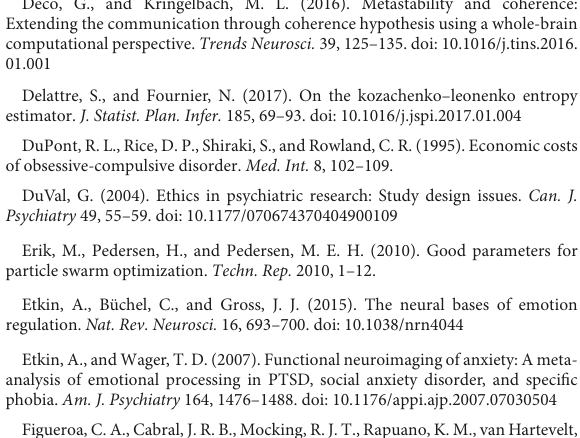
Figueroa,C.A.,Cabral,J.R.B.,Mocking,R.J.T.,Rapuano,K.M.,vanHartevelt, T. J., Deco, G., et al. (2019). Altered ability to access a clinically relevant